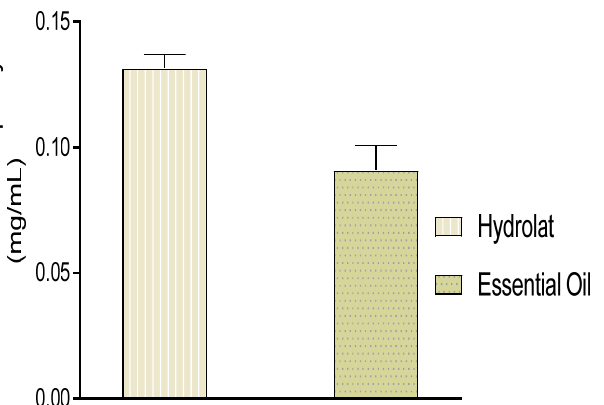
Figure 3. Total antioxidant capacity of essential oils and hydrolat from W. frutescens .